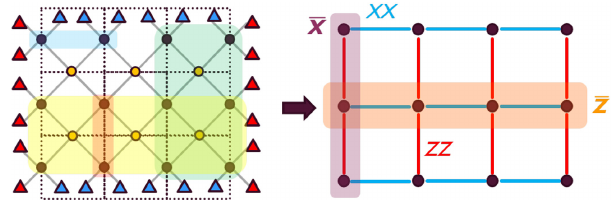
FIG. 10. A 3 × 4 Bacon-Shor code with distance 3 from the surface-code tensor network. Tensors every other row are col- ored yellow, meaning that both on-site dangling legs are logical (pointing out of the page) while the black sites have one dan- gling leg pointing into the page (physical) while the other out of the page (logical). The red and blue triangles are again stop- per tensors we use for the surface code, which are Z and X + 1 eigenstates, respectively. The weight-2 shaded operators are gauge generators (blue, X type; red, Z type) while some stabi- lizers are shaded in yellow ( Z type) and green ( X type). They correspond to acting Pauli X or Z s on the physical qubits (black). Blue and red edges in the right diagram mark the gauge gener- ators. A representative of the logical X ( Z ) operator has X ( Z ) acting on the purple (orange) shaded qubits.